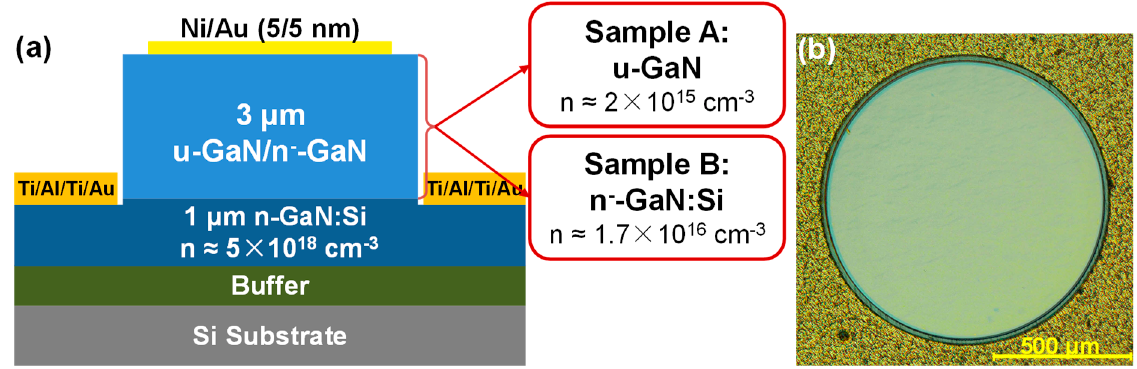
Figure 1. ( a ) Cross-sectional sketch and ( b ) top-view microscopy image of one as-fabricated GaN-on-Si Schottky barrier UV PD.